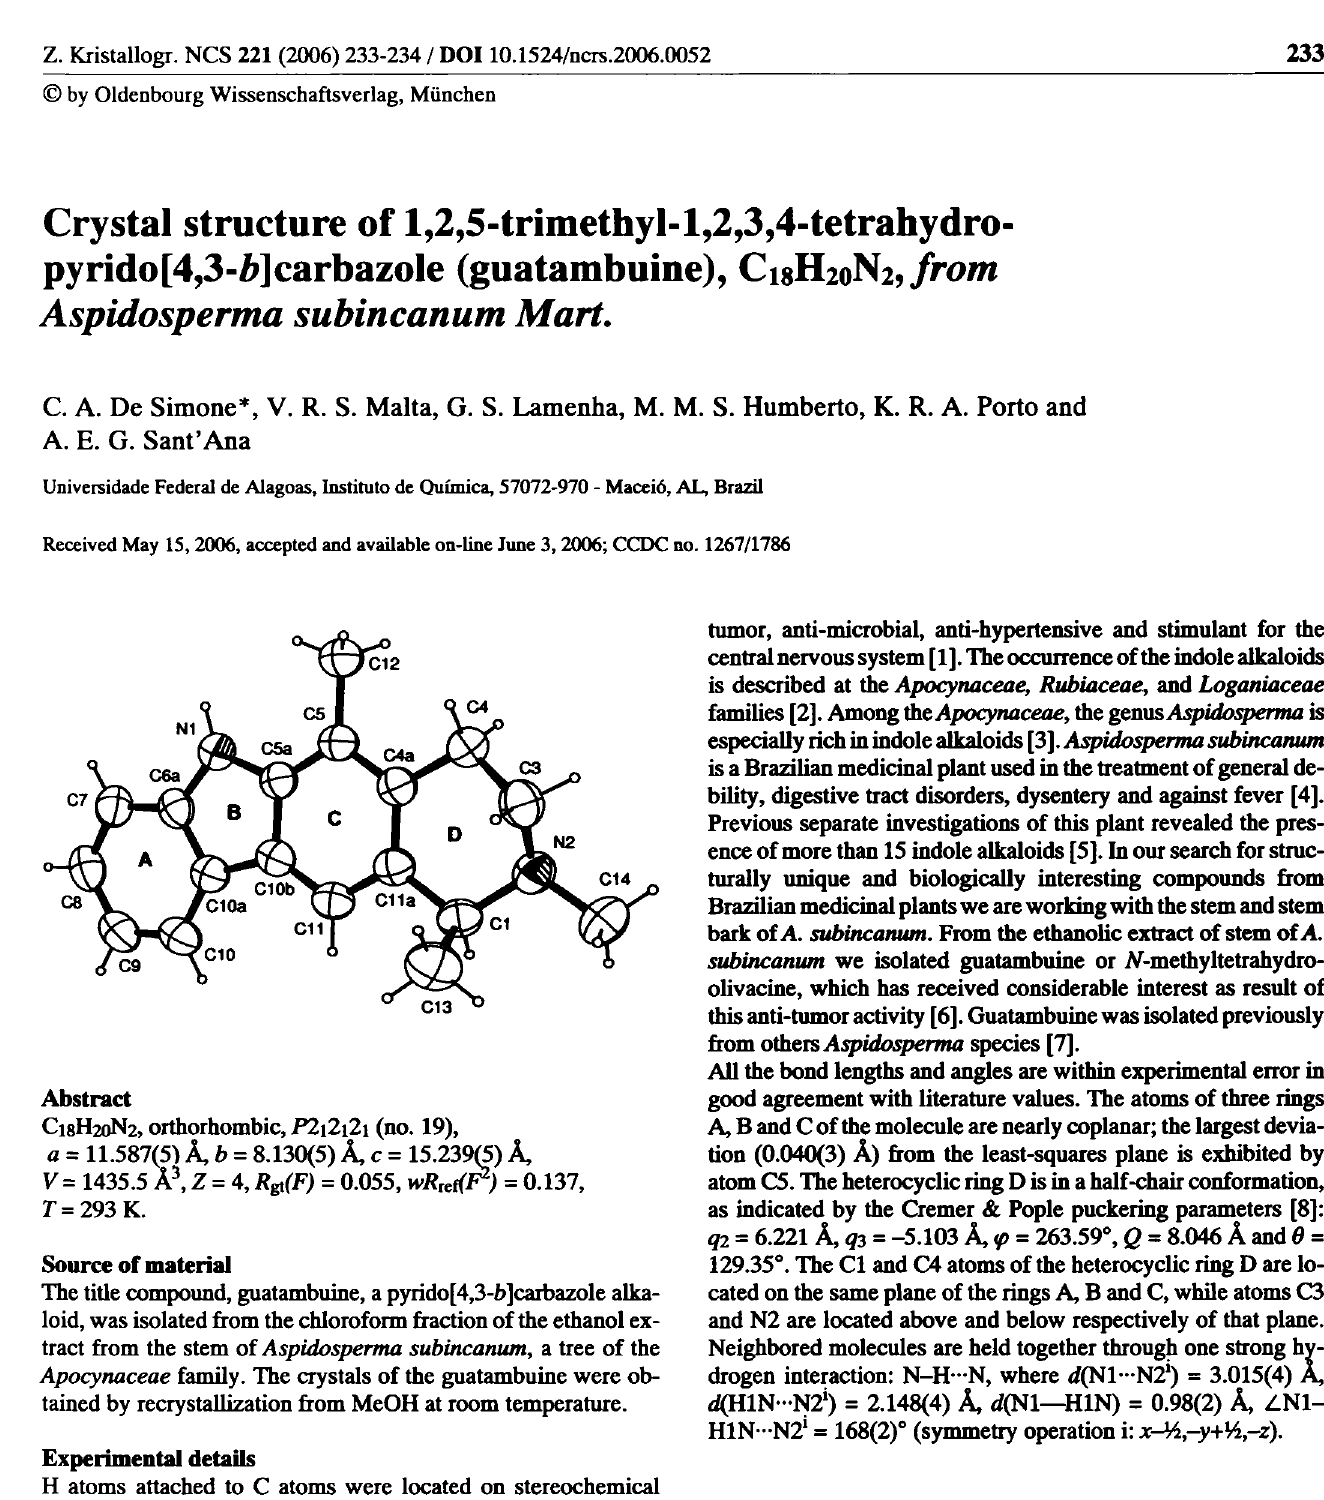
Table 1. Data collection and